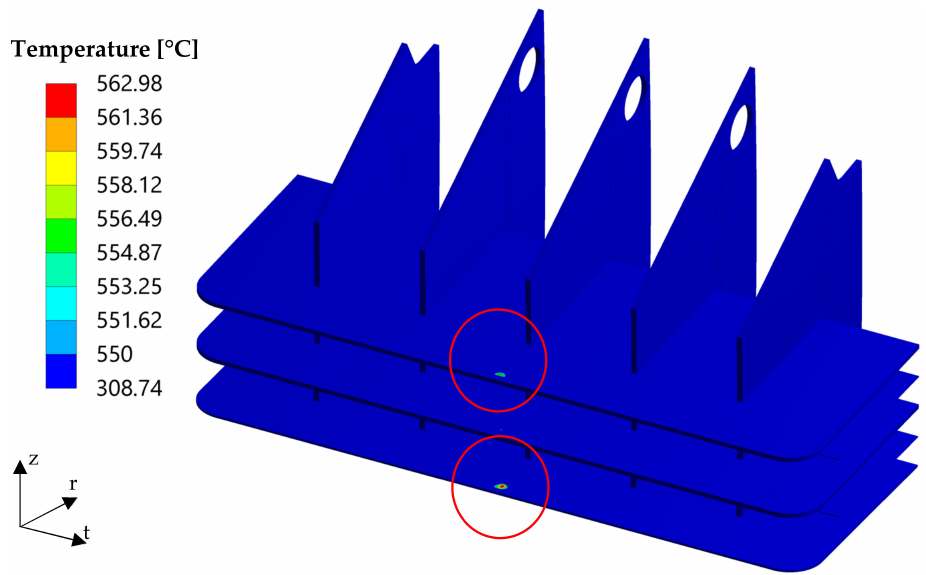
Figure 6. Temperature overtaking 550 ◦ C within SPs